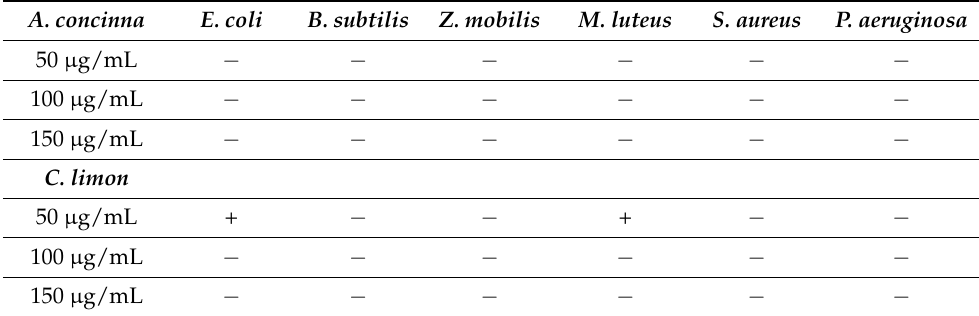
Table 4. MIC of A. concinna and C. limon at 600